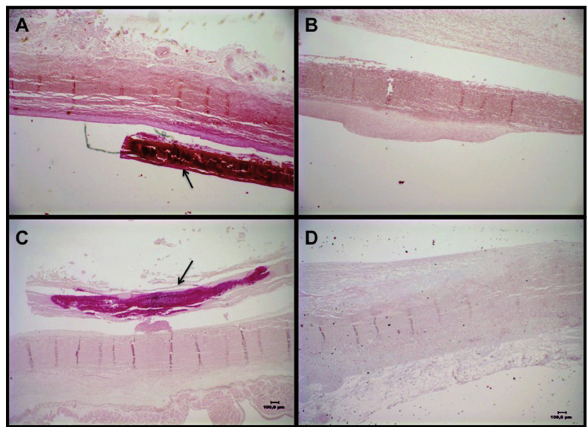
Fig. 3 – Análise histológica. Fotomicrografias em alizarina–red